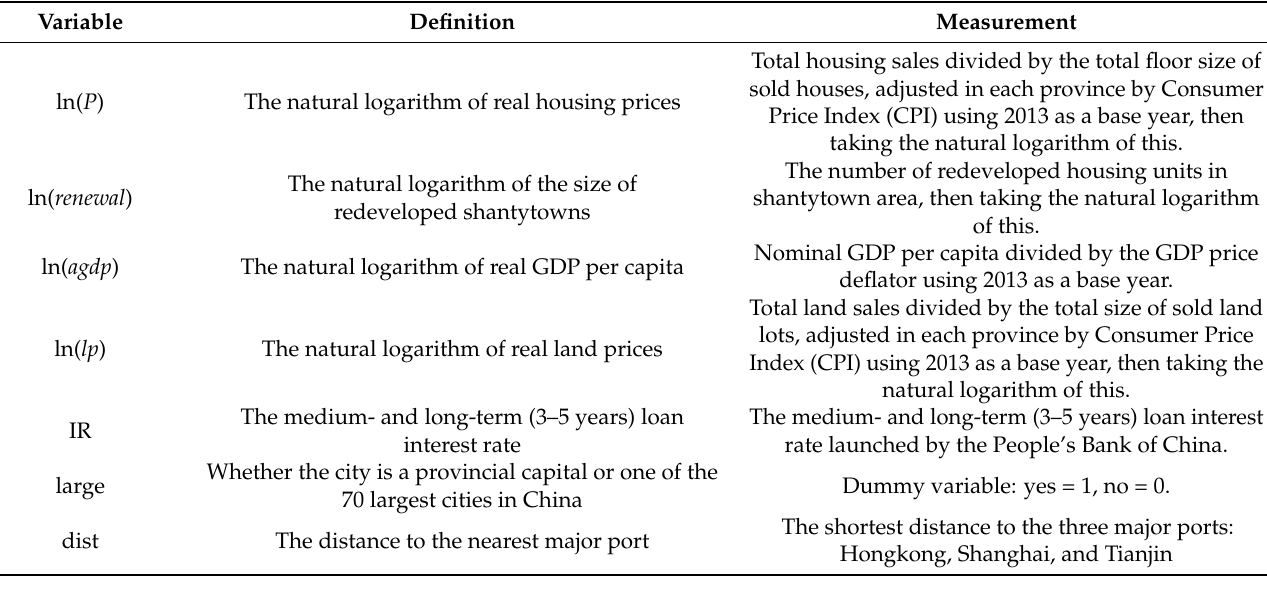
Table 1. The definition and measurement of the main variables.